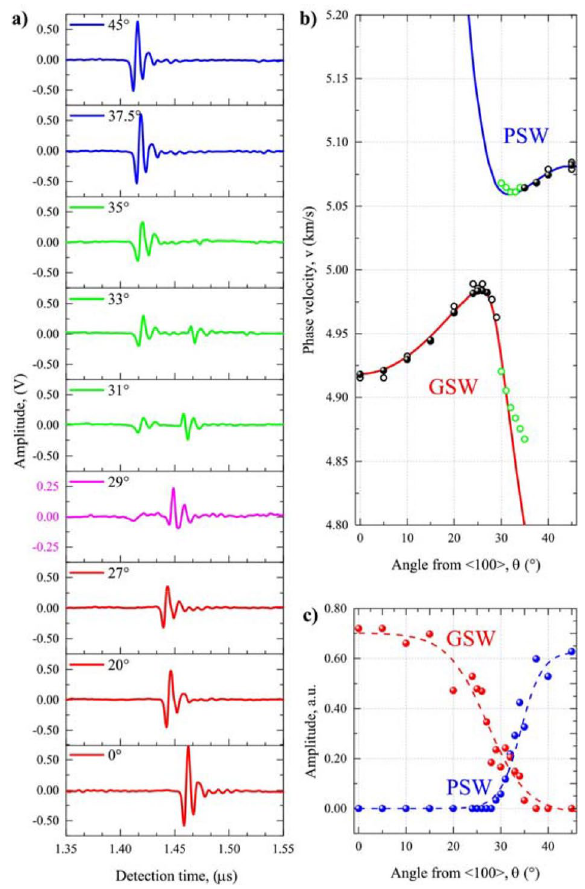
Figure 4. ( a ) The signal waveforms obtained for some representative values of the azimuthal angles θ ; ( b ) The comparison of the experimental data with the calculated dependencies: solid circles represent data from dispersion curves, open circles represent data from time of detection, green circles highlight the simultaneous detection of GSW and PSW; ( c ) The angular variation of the signal intensities: GSW—red and PSW—blue circles. (graph created using a software OriginPro 8.1 SR3 v8.1.34.90, https ://www.origi